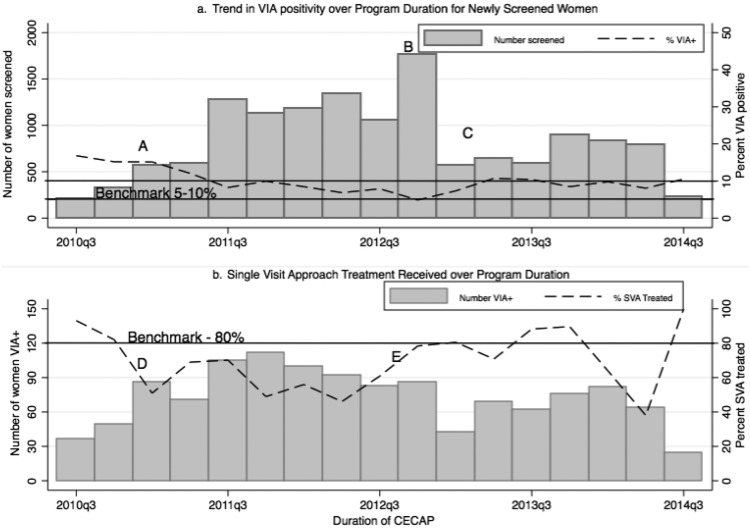
Trends in Cervical Cancer Screening, VIA Positivity, and Treatment, 2 Teaching Hospitals in Burkina Faso, September 2010–August 2014Abbreviations: CECAP, cervical cancer prevention; SVA, single-visit approach; VIA, visual inspection with acetic acid.Notes:A. February 2011: Revision to the data collection tools to differentiate between clients referred for cryotherapy from other centers and clients making initial visits.B. October 2013: Television broadcast on cervical cancer by University Hospital Sorou Sanon.C. January–June 2013: Period without financial resources for supervision and procurement of consumables.D. January 2011: Facilities begin requiring payment for VIA and cryotherapy.E. November 2012: Cost reduction for cryotherapy.